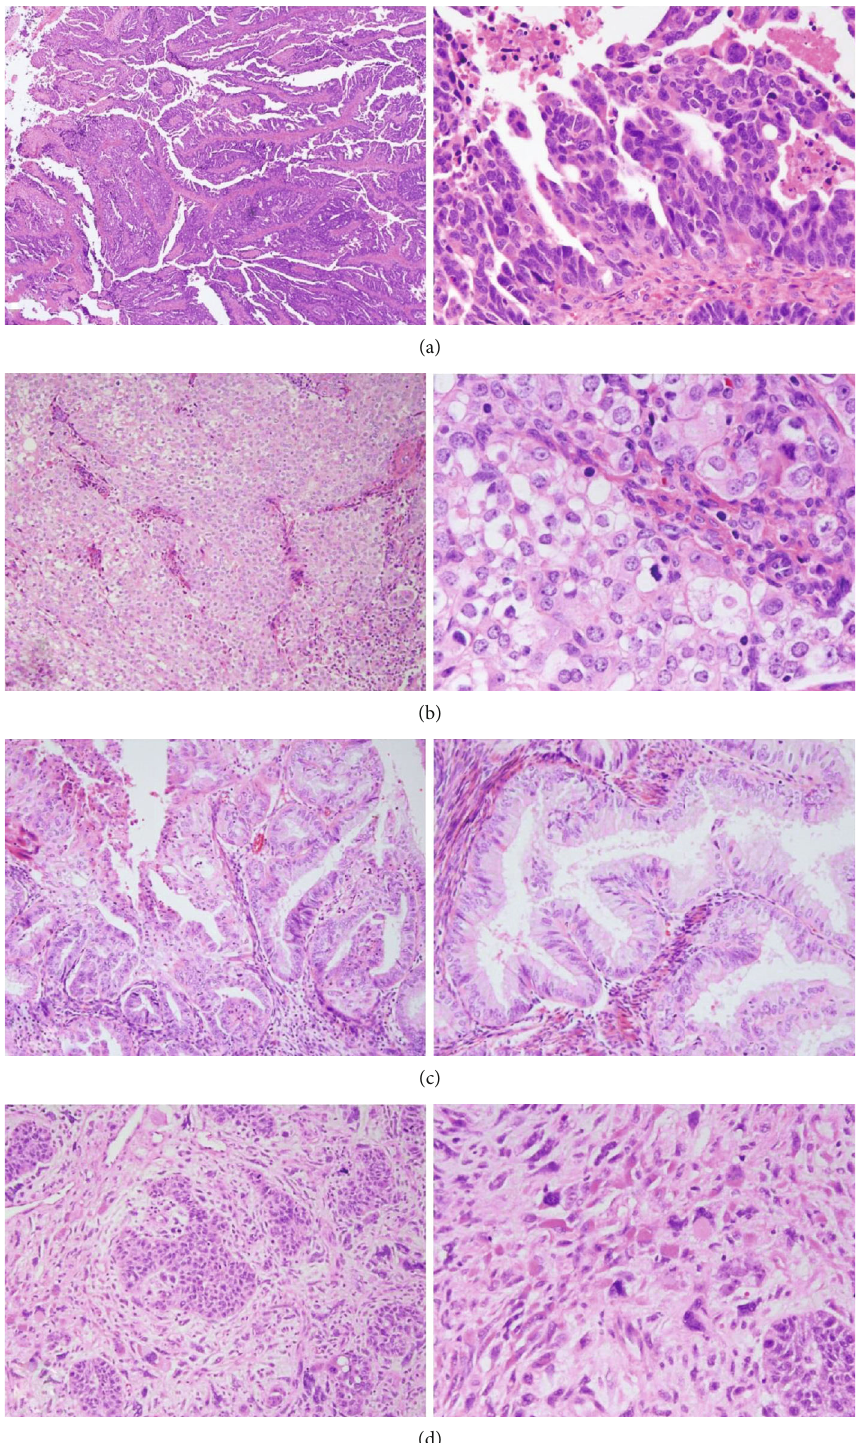
Figure 1: Four examples ((a – d), each a separate case) of GATA3-positive tumors with nonmesonephric histology. (a) Serous. (b) Ambiguous morphology, most consistent with grade 3 endometrioid carcinoma. (c) Conventional grade 1 endometrioid. (d)